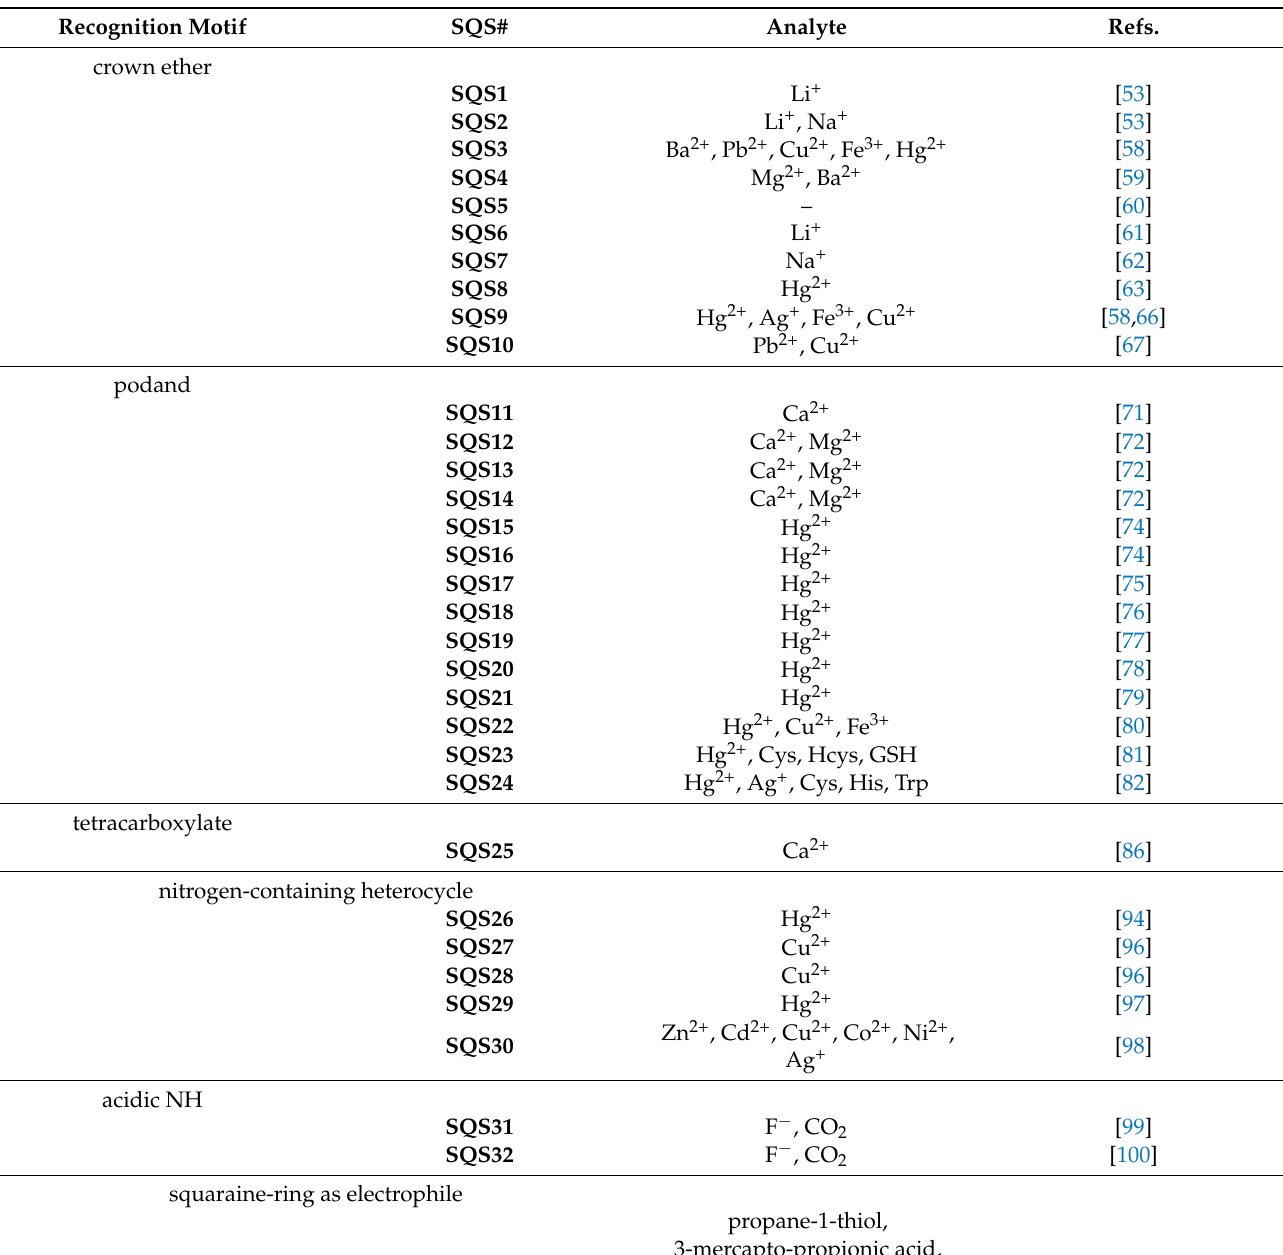
Table 1. A list of SQSs and their recognition motifs for sensing of various